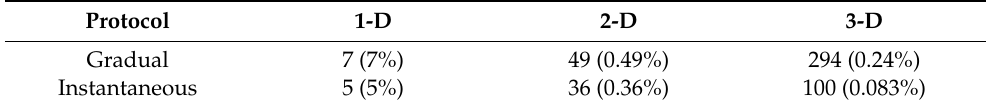
Figure 2. ( A ) Action potential propagation is shown at different times (20 milliseconds (ms), 40 ms, 60 ms, and 80 ms) during the simulation in the 2-D network of 100 × 100 rat ventricular myocytes. ( B ) The corresponding Ca 2+ wave propagation in the 2-D network. Table 1. Number and percentage of myocytes with the instantaneous and gradual current injection in 1-D, 2-D, and 3-D